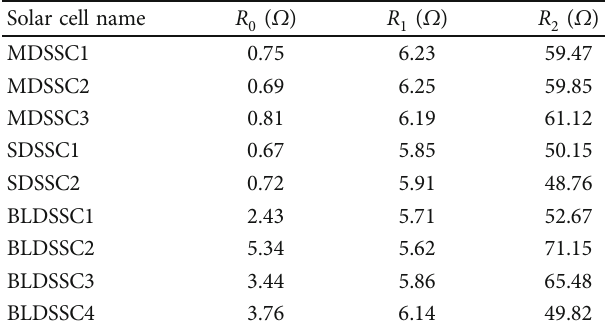
Figure 8: The achieved Nyquist diagrams from EIS analysis of fabricated solar cells. Table 3: The resistances of fabricated solar cells achieved from EIS